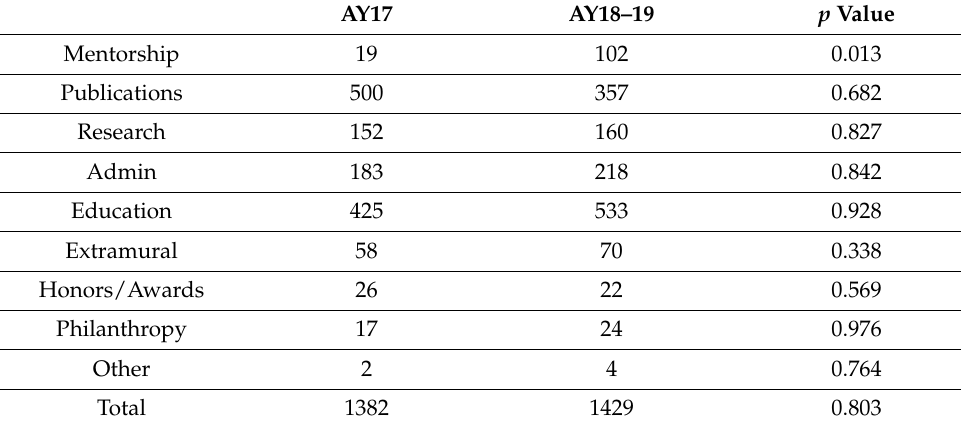
Table 2. Total average points awarded in AY17 compared to AY18–19. Mann–Whitney U pairwise testing of points awarded before and after implementation of monetary